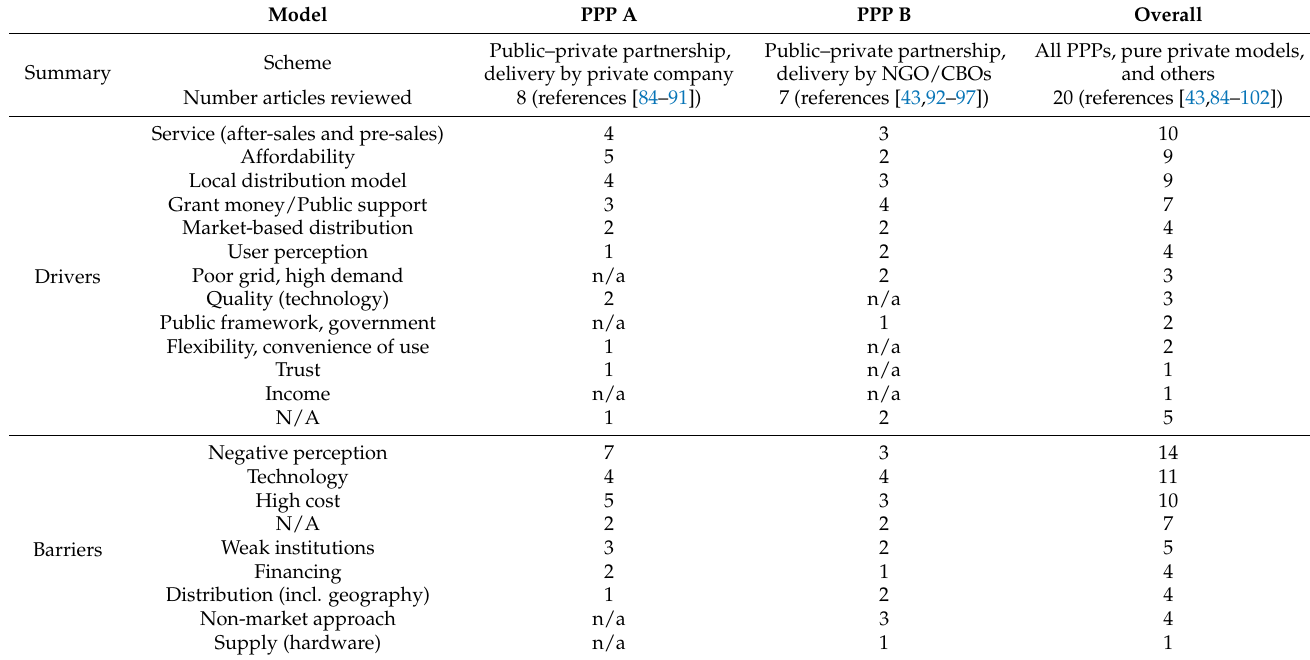
Table 2. Quantifying drivers and barriers cited in reviewed articles. Note: The driver of “Local distribution model” includes distribution factors such as unbundled distribution, type of actors, role of local initiatives, civil society and local commitments. The driver of “User perception” references openness to new technology, awareness, and education. The barrier of “Negative perception” includes lack of awareness and distrust; The barrier of “Technology” includes technology failure or lack of maintenance. The barrier of “Weak institutions” includes the role of governance structures, management activities, as well as local organizations.